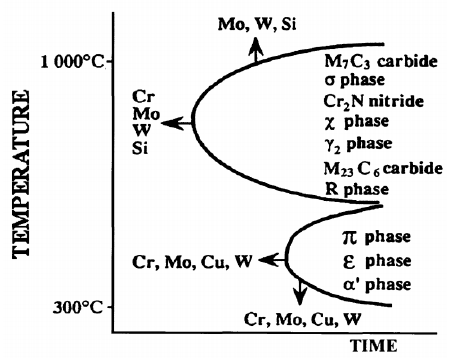
Figure 5. Isothermal cooling curve for the ternary Fe-Cr-Ni system showing the effect of alloying addition on the precipitation of the secondary phases that can form upon cooling [75].